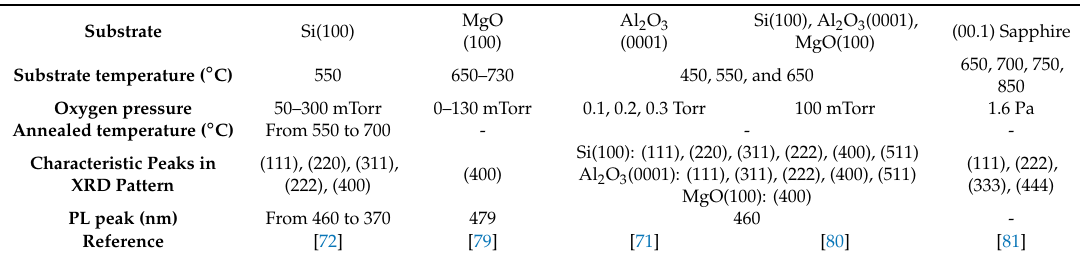
Table 4. Comparisons of PL peaks and crystalline orientations with di ff erent process parameters in the pulsed laser deposition (PLD)